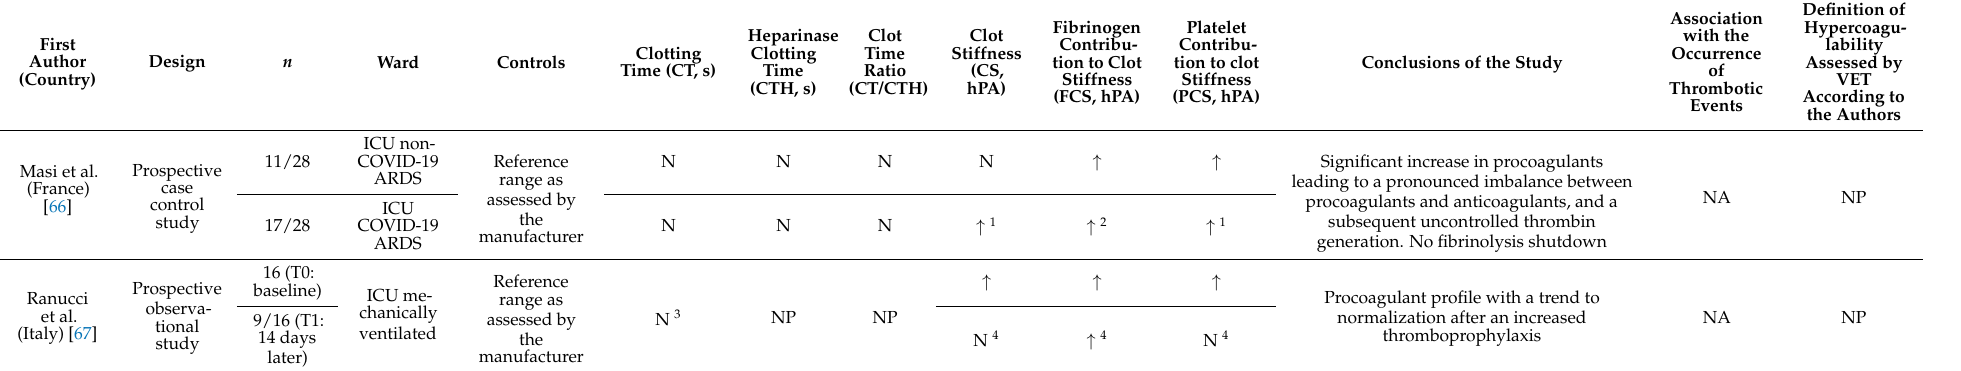
Table 9. Main findings of studies reporting Quantra results using the QPlus